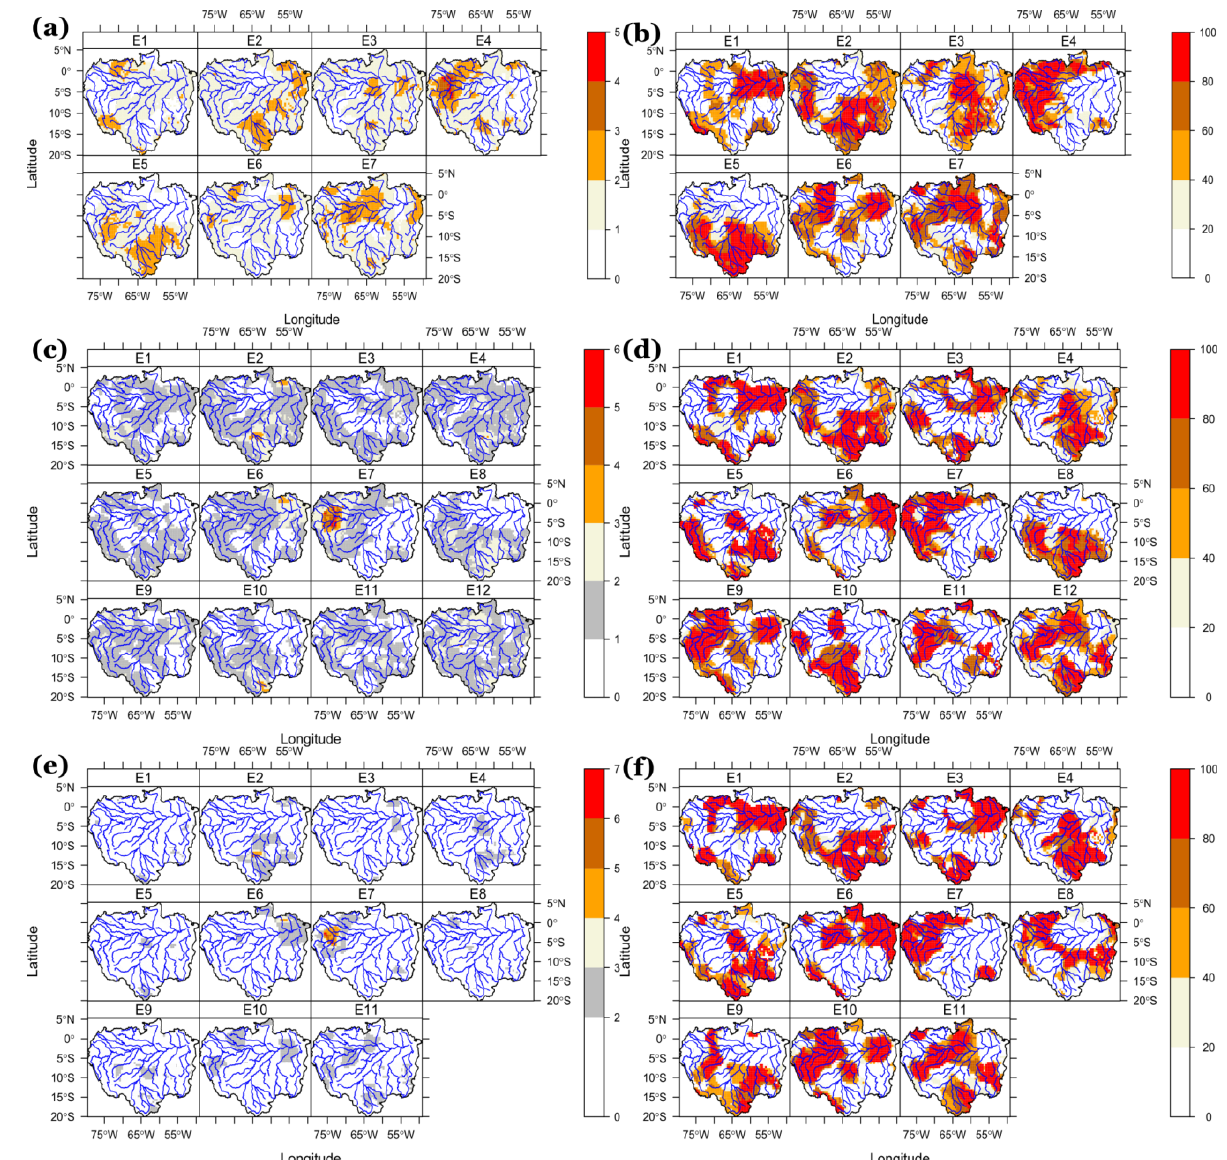
Figure 6. Spatial distribution of the intensity [-] and the temporal persistence [%] during the occurrence of the: ( a , b ) SPEI3-based extreme drought events; ( c , d ) SPEI6-based extreme drought events; and ( e , f ) SPEI12-based extreme drought events over the ARB during 1901–2018. The main features of the extreme drought events are shown in Table 2. The temporal persistence is the percentage of the total duration of the extreme drought event on a pixel-level.